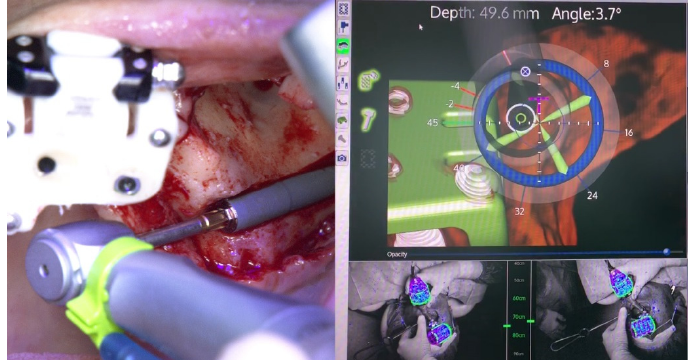
Figure 26. Perioperative preparation of the zygomatic implant using live navigation. Note the data on the image considering depth and angle.